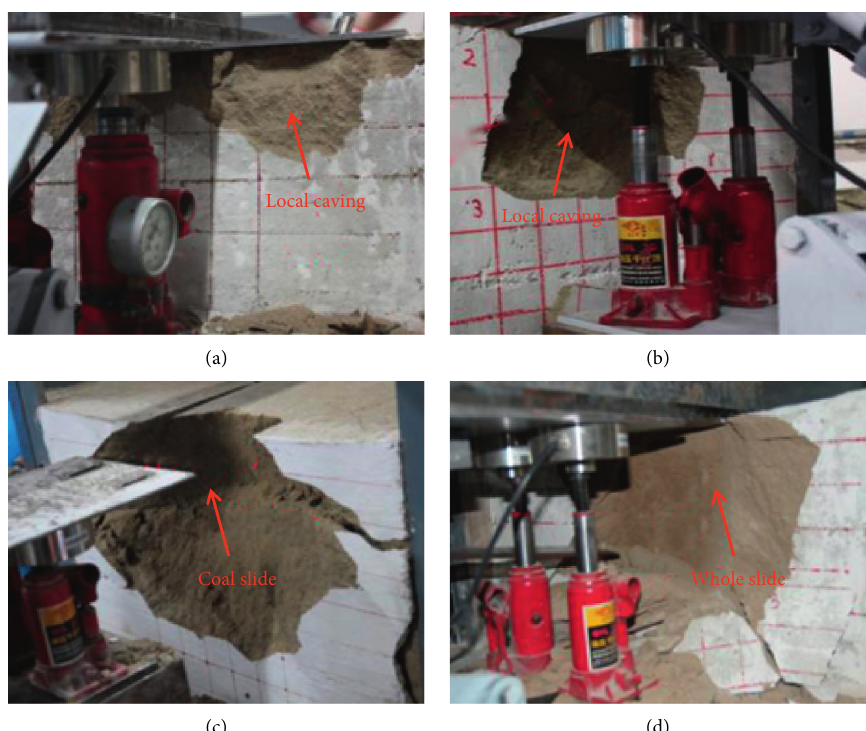
Figure 7: Variation in the failure modes of a simulated coal wall as a function of simulated mining height. (a) Mining height 3m. (b) Mining height 5 m. (c) Mining height 7m. (d) Mining height 9m.